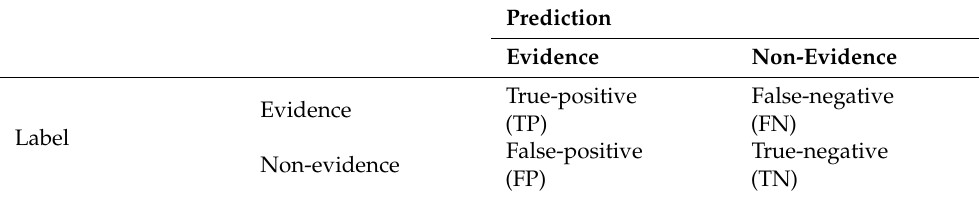
Table 5. Confusion